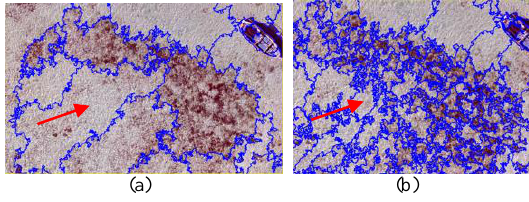
Fig. 5. Image segmentation results, (a) normal, and (b) over